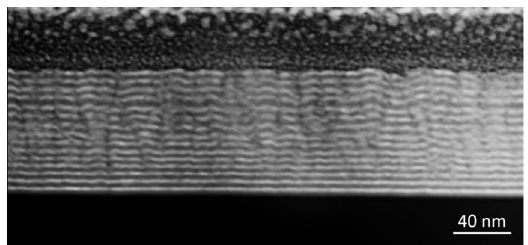
Figure 4. STEM dark-field image of a lamella with Pd/CeO 2 multilayer (each layer is less than 5 nm thick). The lamella was prepared by FIB/SEM methods.